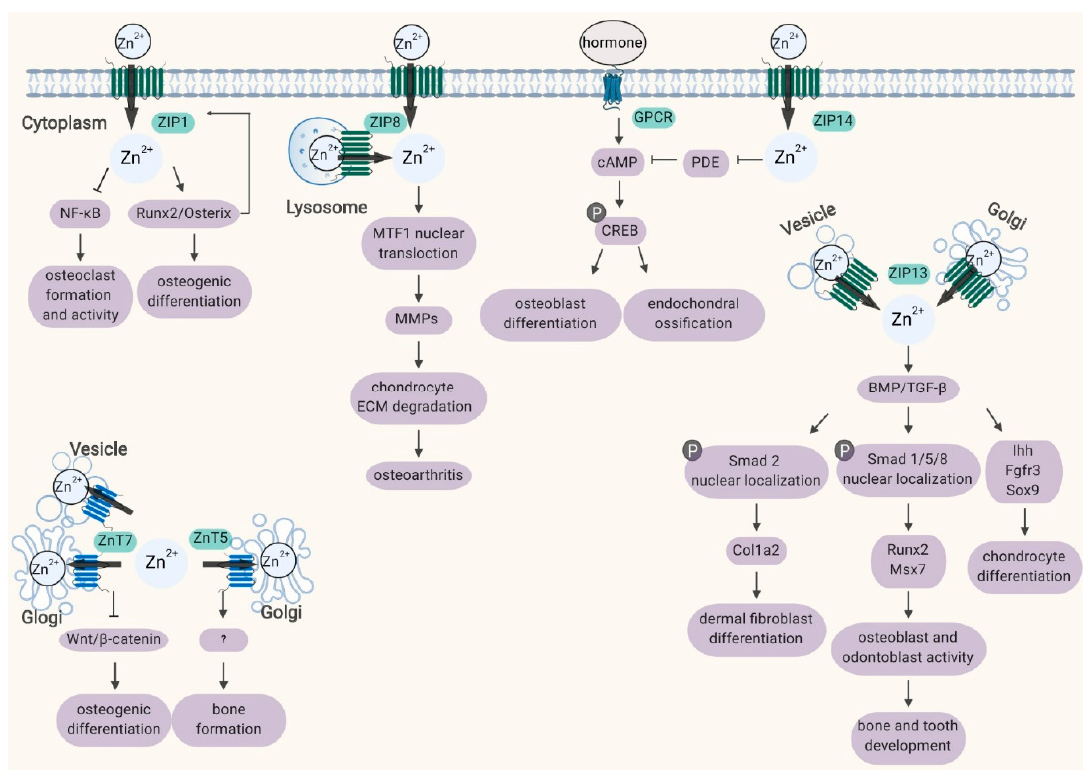
Figure 1. Schematic diagram of the subcellular localization and biological processes of ZIP and ZnT proteins involved in bone homeostasis. Refer to the text for a detailed description. Abbreviations: MTF1, metal-regulatory transcription factor-1; MMPs, matrix metalloproteinases; GPCR, G protein-coupled receptor; PDE, phosphodiesterase; CREB, cAMP response element-binding protein; BMP, bone morphogenetic protein.